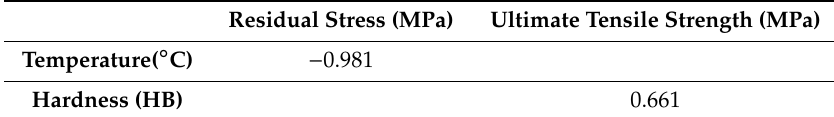
Pearson correlation coe ffi cient between properties of ferritic stainless steel and annealing temperature.